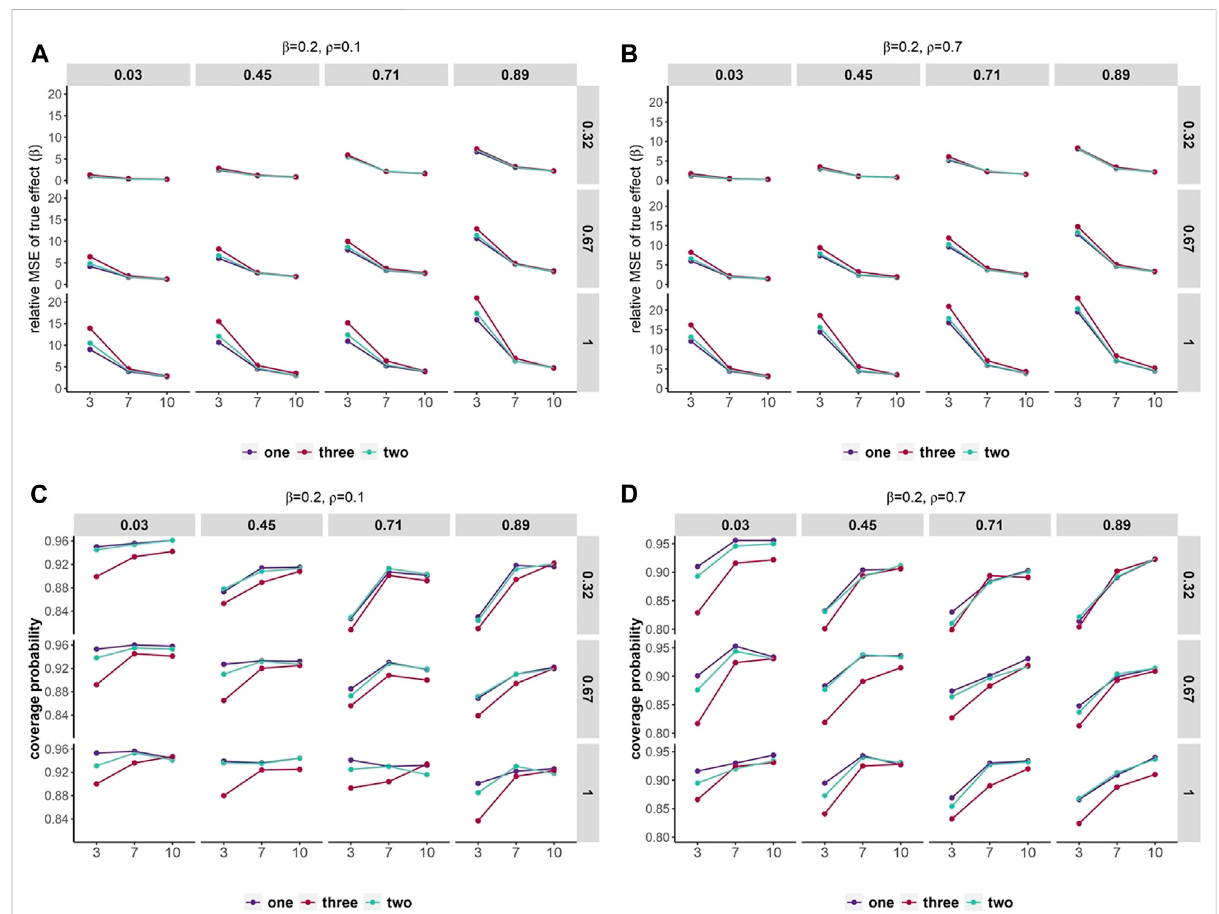
FIGURE 4 Mean squared error and coverage probability of overall effect estimates. Scenarios containing various within-study variances (row) and heterogeneity across studies (column). The x -axis represents the number of studies and the y -axis shows the relative MSE (A,B) and coverage probability of 95% con fi dence intervals (C,D) . Set overall effect β = 0.2. Different colors represent a number of duplication or non-independent effects across